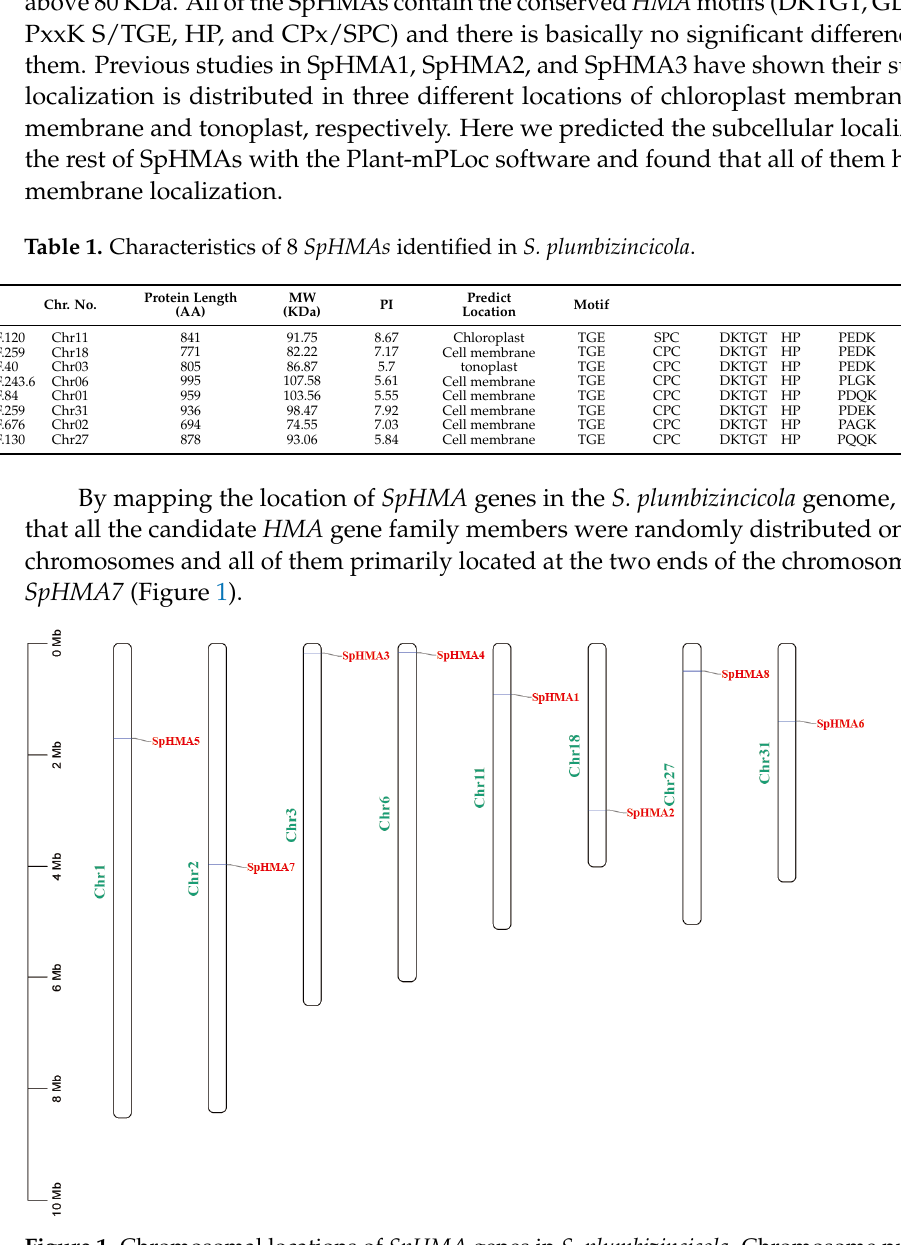
Figure 1. Chromosomal locations of SpHMA genes in S. plumbizincicola . Chromosome numbers are shown at the left of the bar with green font. SpHMA genes are labeled at the right of the chromosomes with red font. Scale bar on the left indicates the chromosome lengths (Mb).